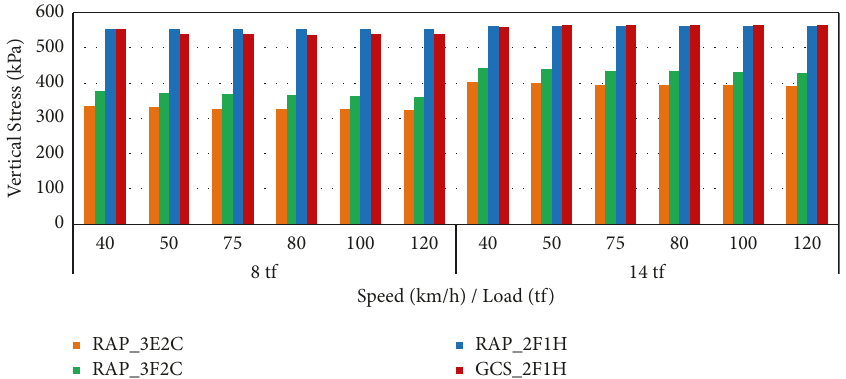
Figure 6: Influence of the speed and load magnitude on the vertical